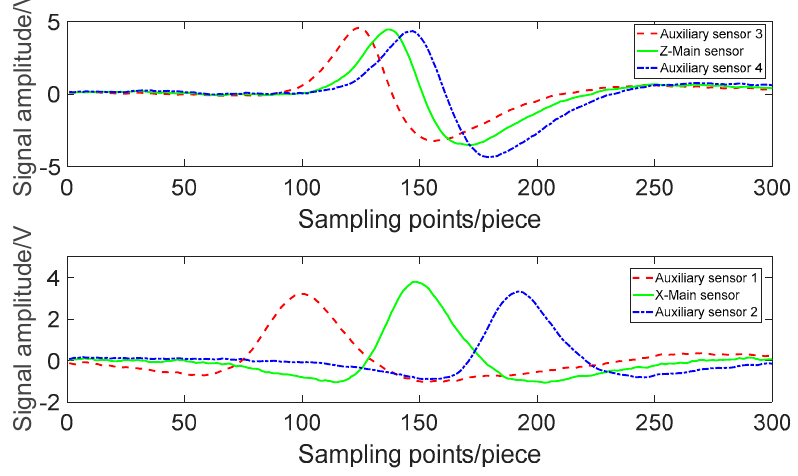
Figure 17. Single defect.